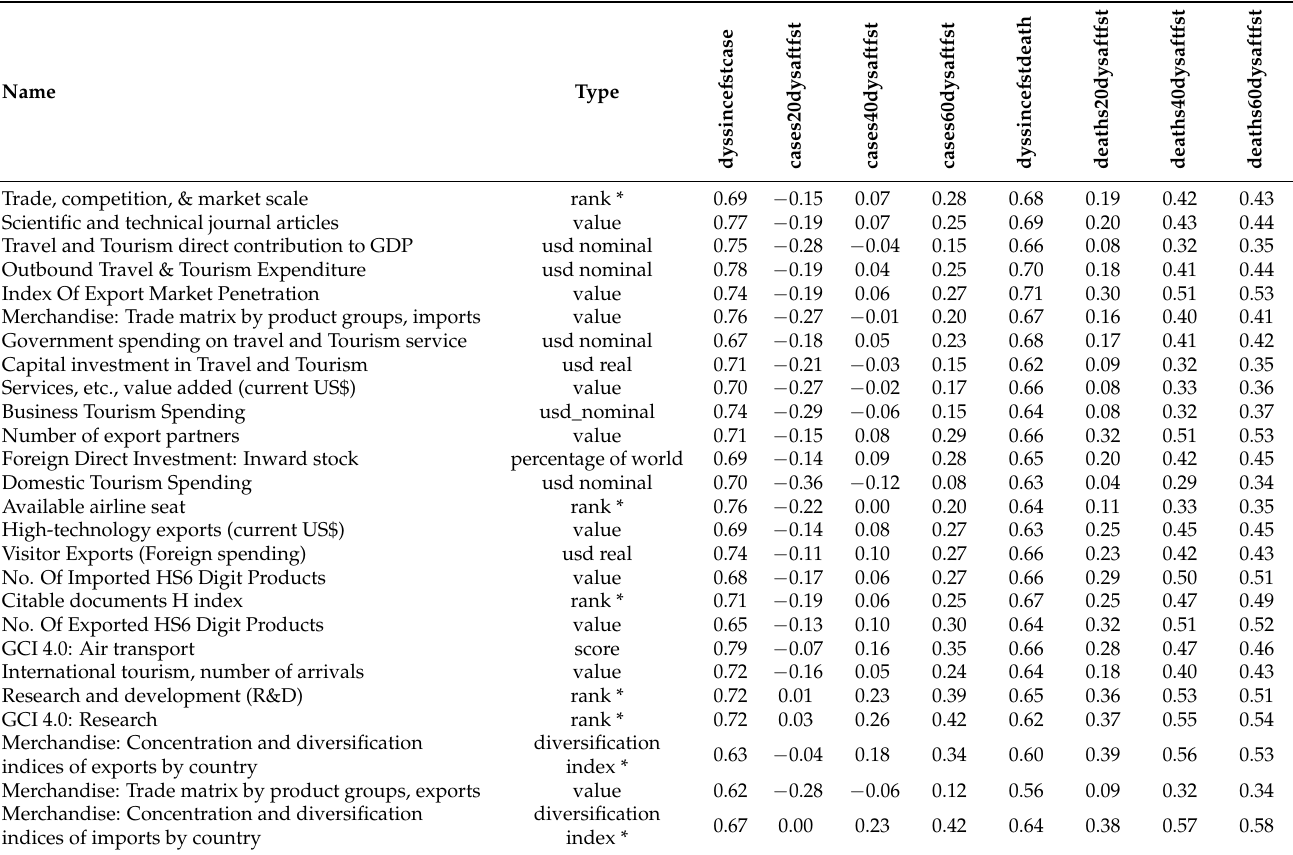
Table A1. Standalone correlations in the tourism and trade community. Spearman rank correlations between COVID-19 variables and indicators of the tourism and trade community in the worldwide dataset.